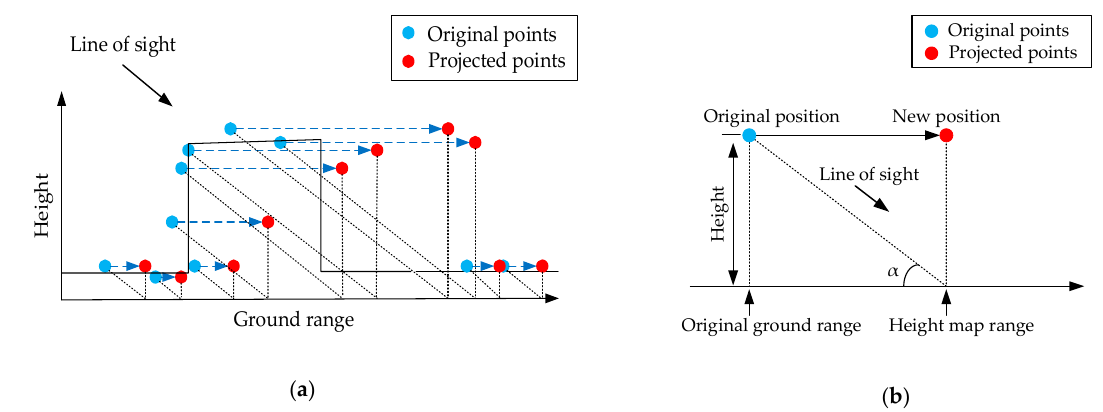
Figure 6. Projection diagram. ( a ) Transformation progress of the surface scatterers. Black dotted lines denote the triangle relationship, and blue dotted lines denote the change before and after the projection. ( b ) The triangle relationship between the look-down angle and the original point height.